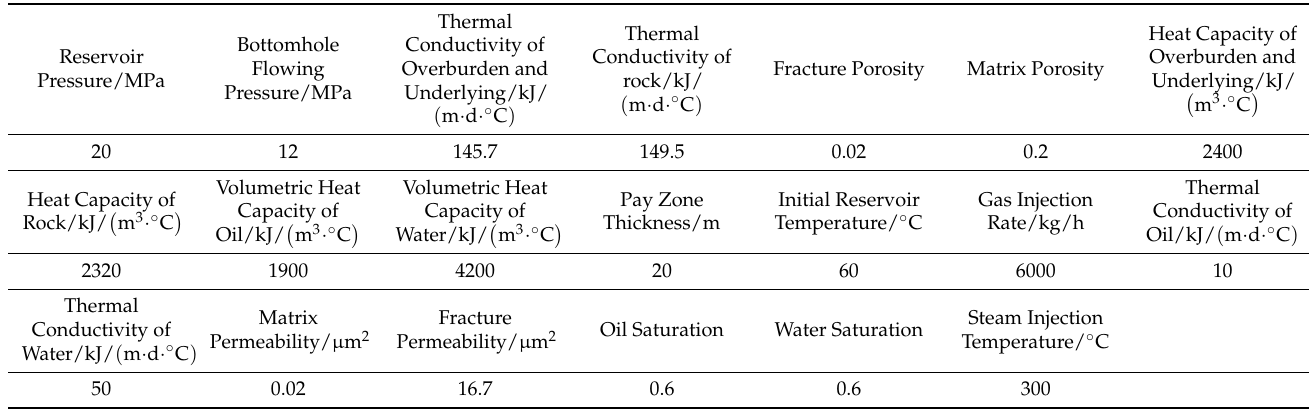
Table 1. Model calculation parameters.